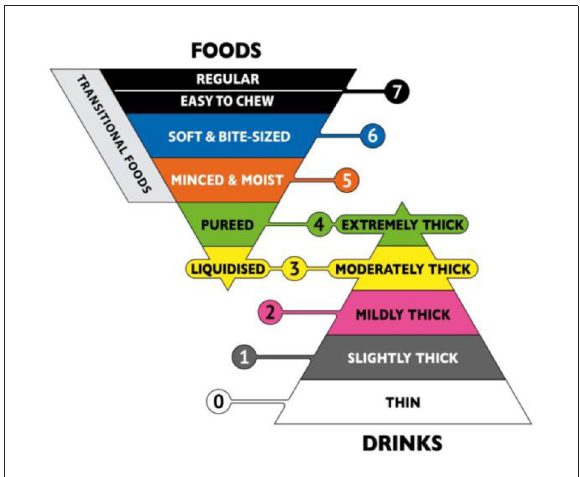
FIGURE1 The International Dysphagia Diet Standardization Initiative framework. Reprinted with permission from Hind et al.